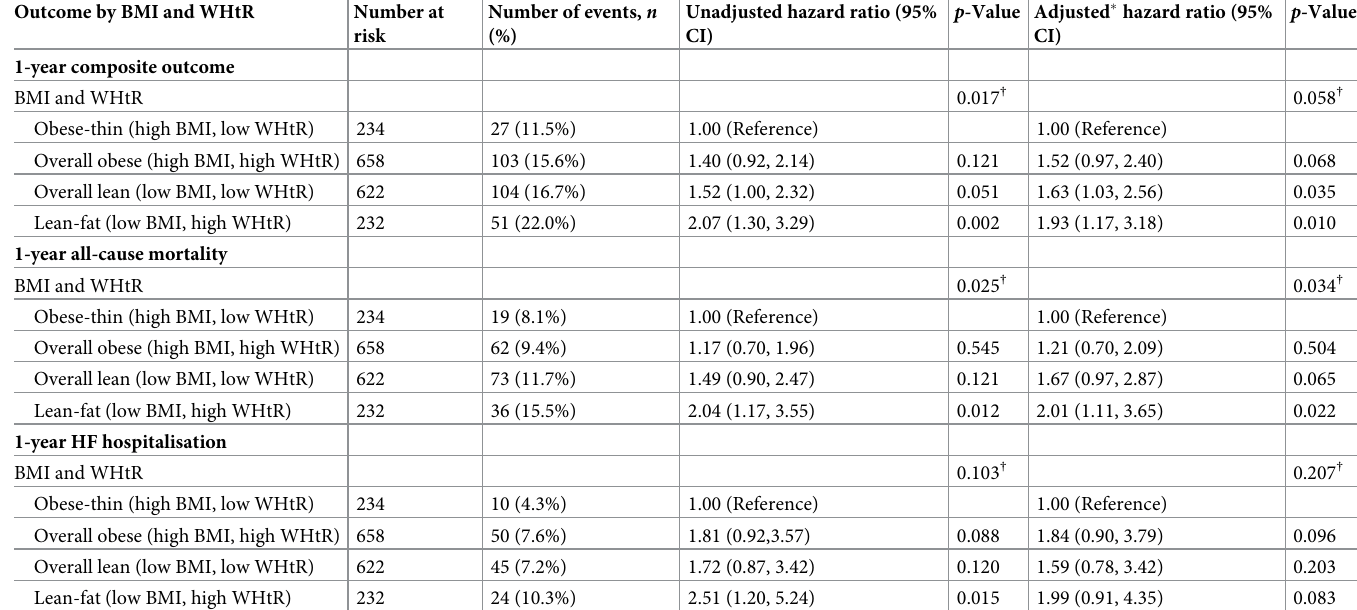
Table 2. Association of BMI and WHtR with outcomes.